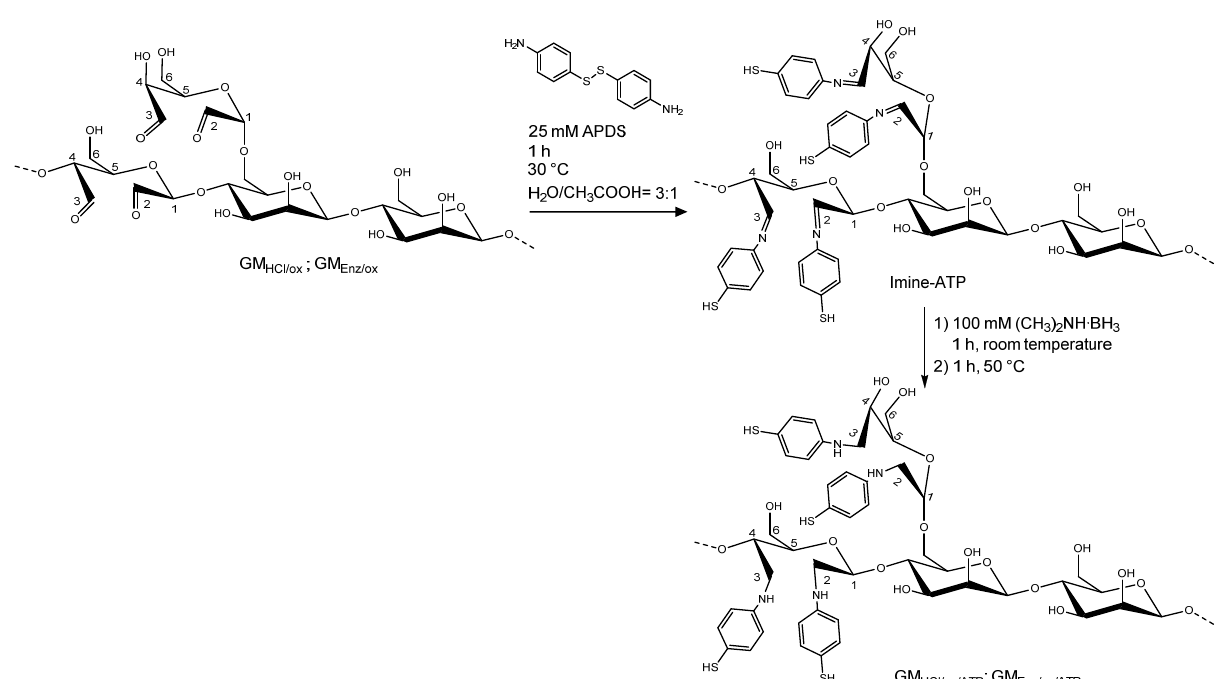
Figure 3. Schematic representation of the reductive amination on an oxidized galactomannan chain. The first reaction consists of the conversion of carbonyl group to the intermediate imine. Secondly, the introduction of a reducing agent reduces the imine to the respective amine. The structure of the fibers is only partially represented and only a small percentage of repeating units per polymer chain are actually labelled.